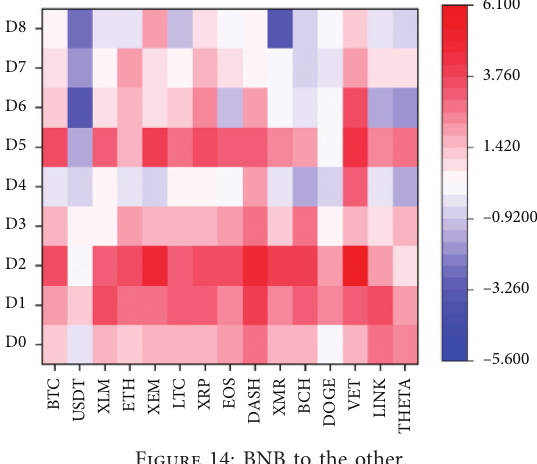
Figure 14: BNB to the other.